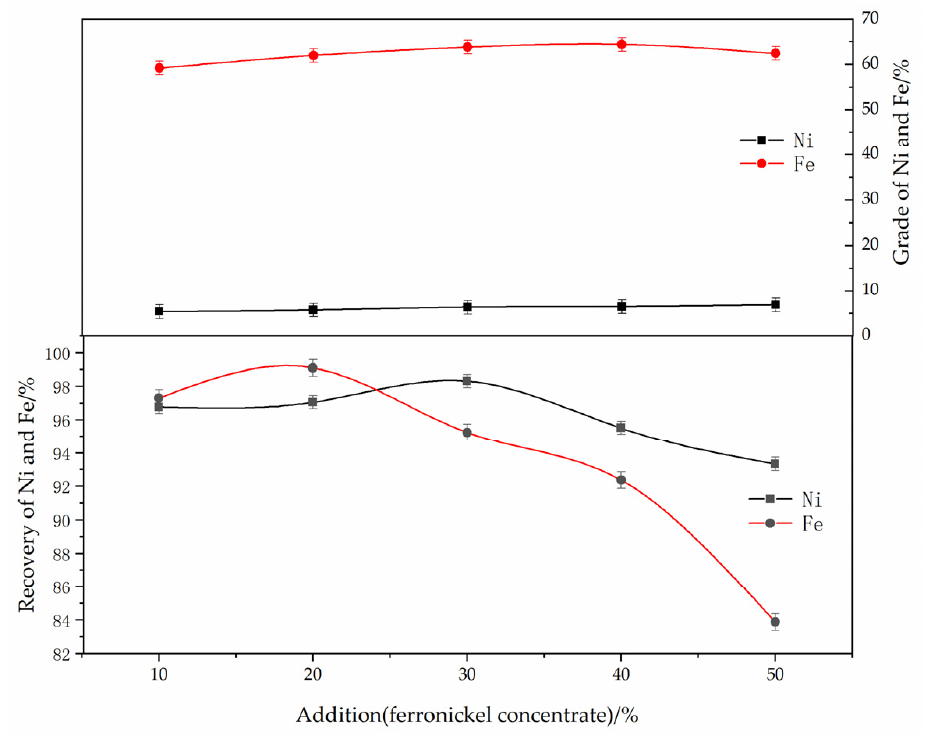
Figure 5. The effect of ferronickel concentrate dosage on the grade and recovery of nickel and iron. (The reducing temperature was 1250 °C, the roasting duration was 60 min, the reductant dosage was 8 wt.%, the magnetic separation was 150 mT).